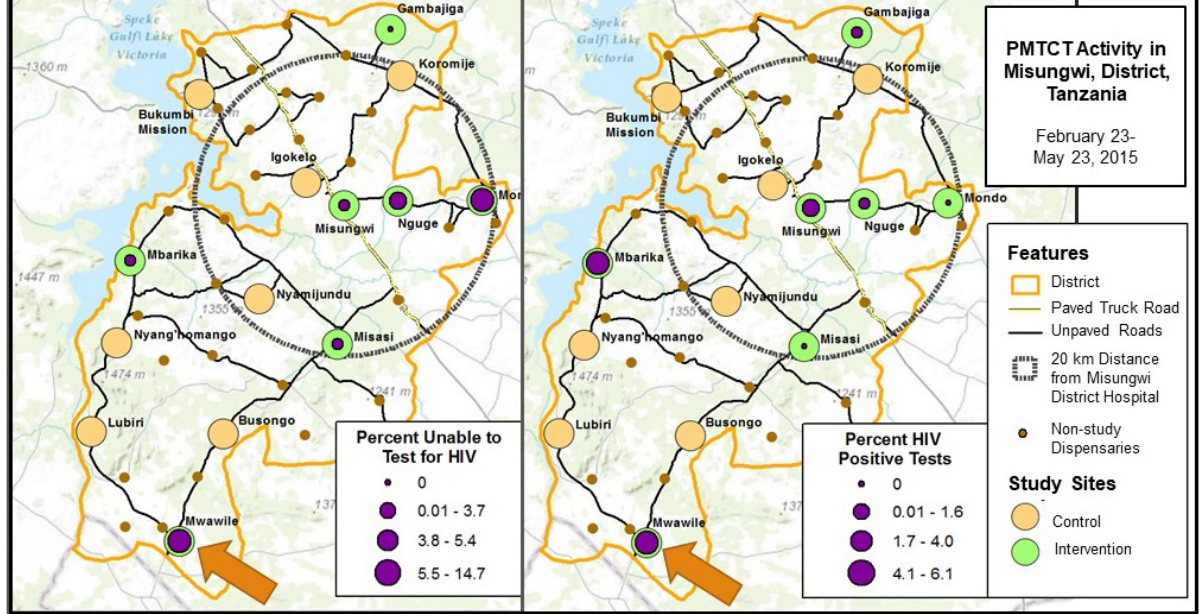
Figure 2 offers a mapped depiction of the distribution of intervention and control sites, along with HIV incidence and testing patterns in intervention sites. The small orange-brown dots represent the location of 28 dispensaries not randomized into the study. The large orange circles are the control sites and the green circles, the intervention sites. The graduated purple circles inside the intervention sites show the percentage of HIV positive tests captured in the T-HIT system on the right map and the percentage of unable to test. Bukumbi Mission and Misungwi are the two hospitals and Misassi, Koromije, Mbarika, and Busongo the health centers. As highlighted with an arrow at the bottom of each map, one site, Mwawile Dispensary, for HIV (shown on the left) and simultaneously a high incidence of HIV among women testing (shown on the right).